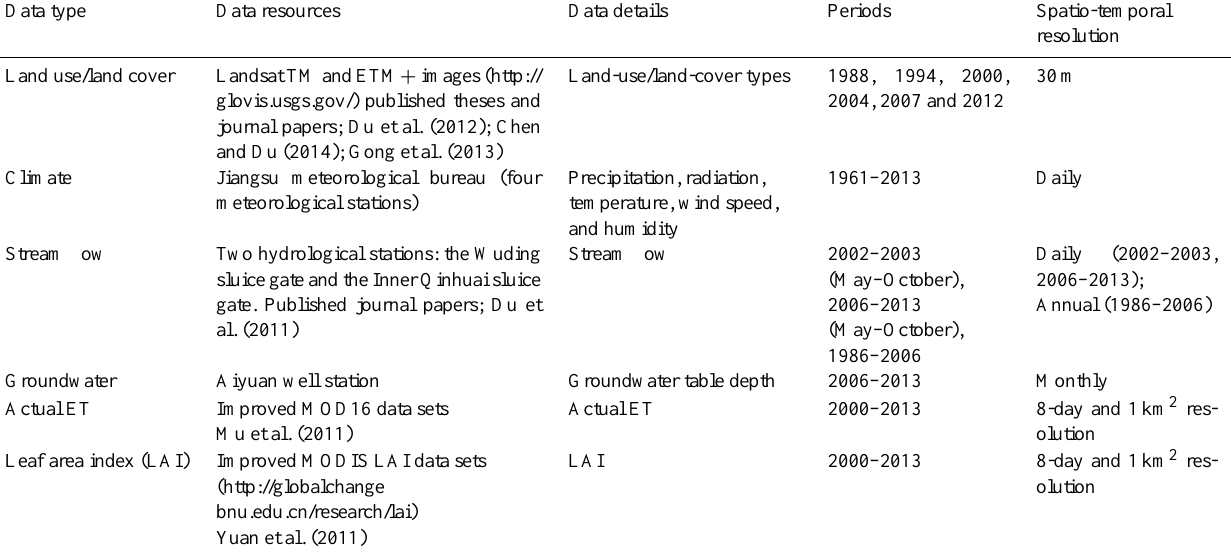
Table 1. A summary of land use, climate, and hydrology data